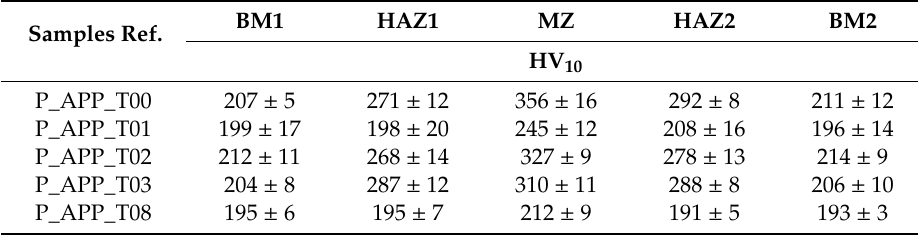
Table 6. Surface microhardness of the di ff erent samples (HV 10 ). HAZ: heat-a ff ected zone, MZ: melted